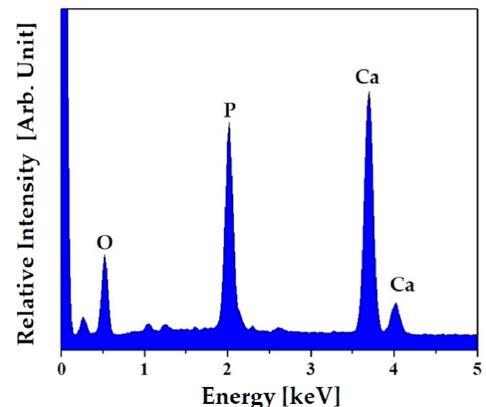
Figure 12. Energy dispersive spectrometry (EDS) spectrum of the apatite crystals formed onto the PCL–CaP composite scaffolds produced with a CaP content of 20 wt%.